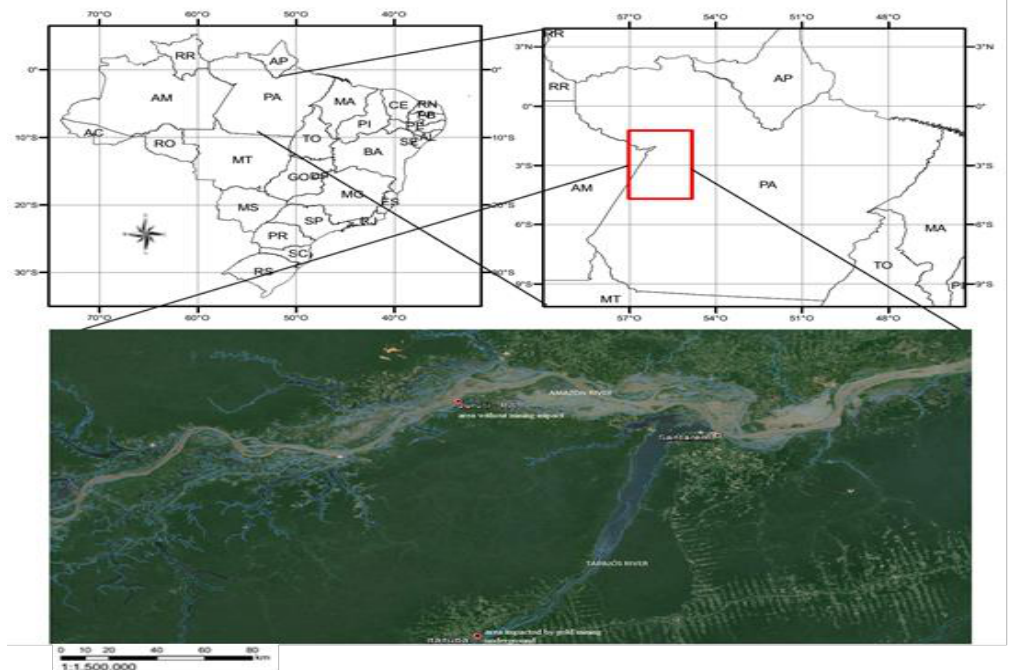
Figure 1: Location of sampling sites (Itaituba municipality - Barreiras community (area impacted by gold mining underground) and Juruti municipality - Tabatinga community (area without mining impact). The region delimitate for rectangle correspond at Tapajós basin